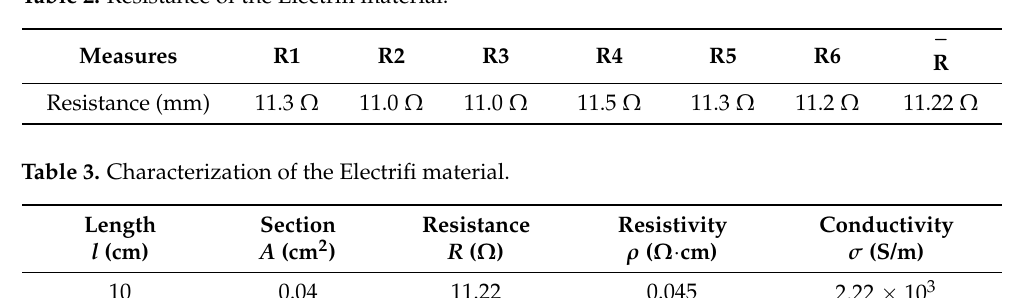
Table 2. Resistance of the Electrifi material.